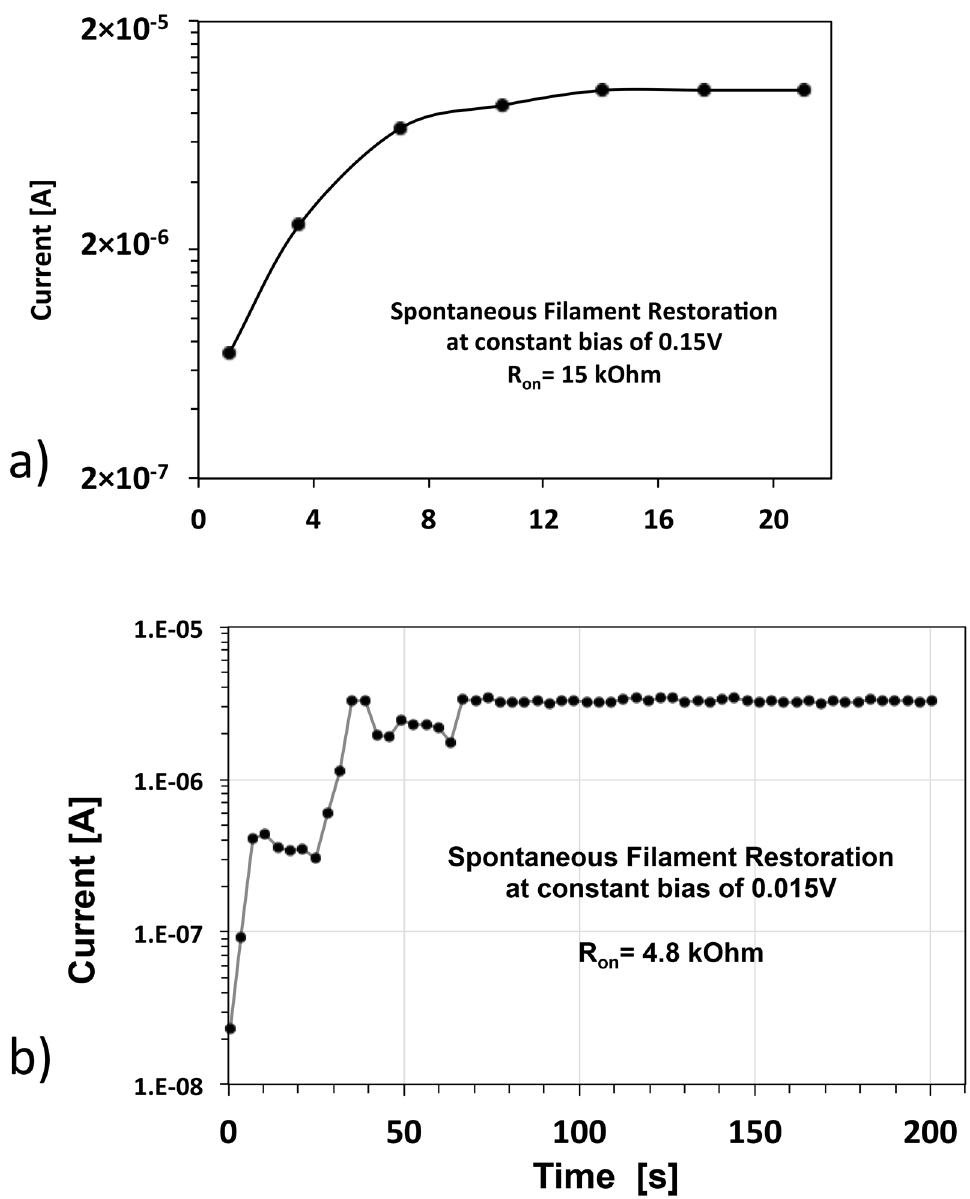
Figure 3. ( a ) Temporal evolution of the current through a cell X 1 just after the heating of the heart source cell A measured at a constant bias of 0.150 V. The cell X 1 has been initially preset to an ON-state with R on = 15 kΩ. ( b ) Temporal evolution of the current through a cell Y 1 just after the heating of the heart source cell A measured at a constant bias of 0.015 V. The cell Y 1 has been initially preset to an ON-state with Ron = 4.8